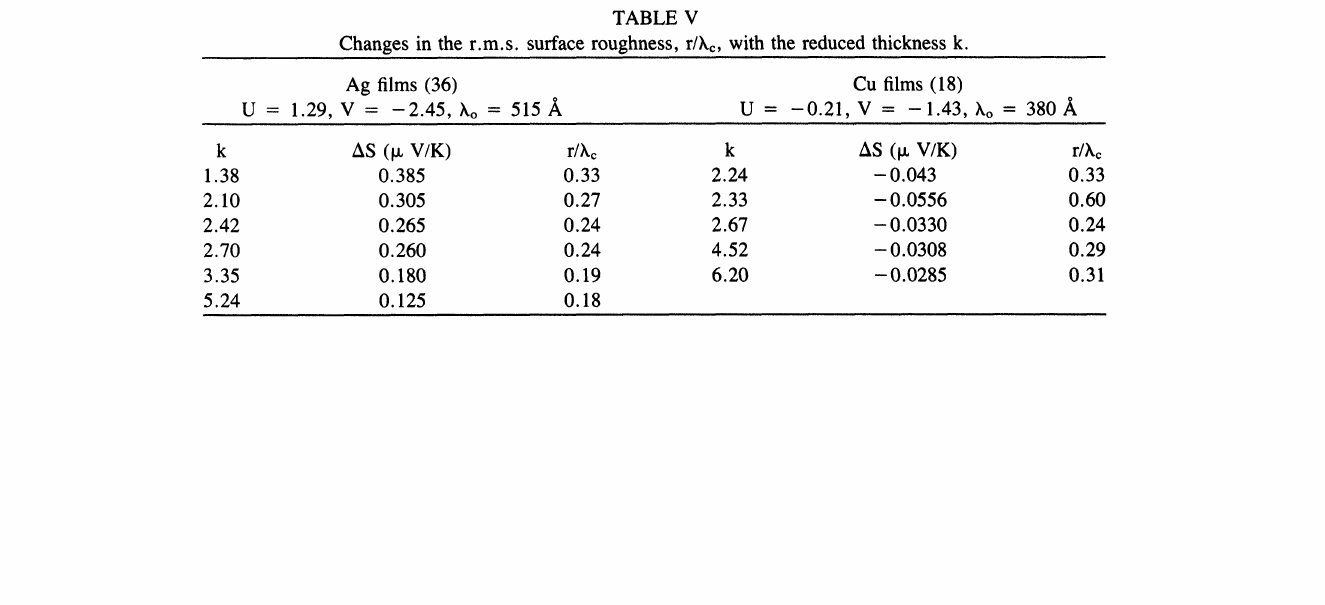
Changes in the r.m.s, surface roughness, r/he, with the reduced thickness